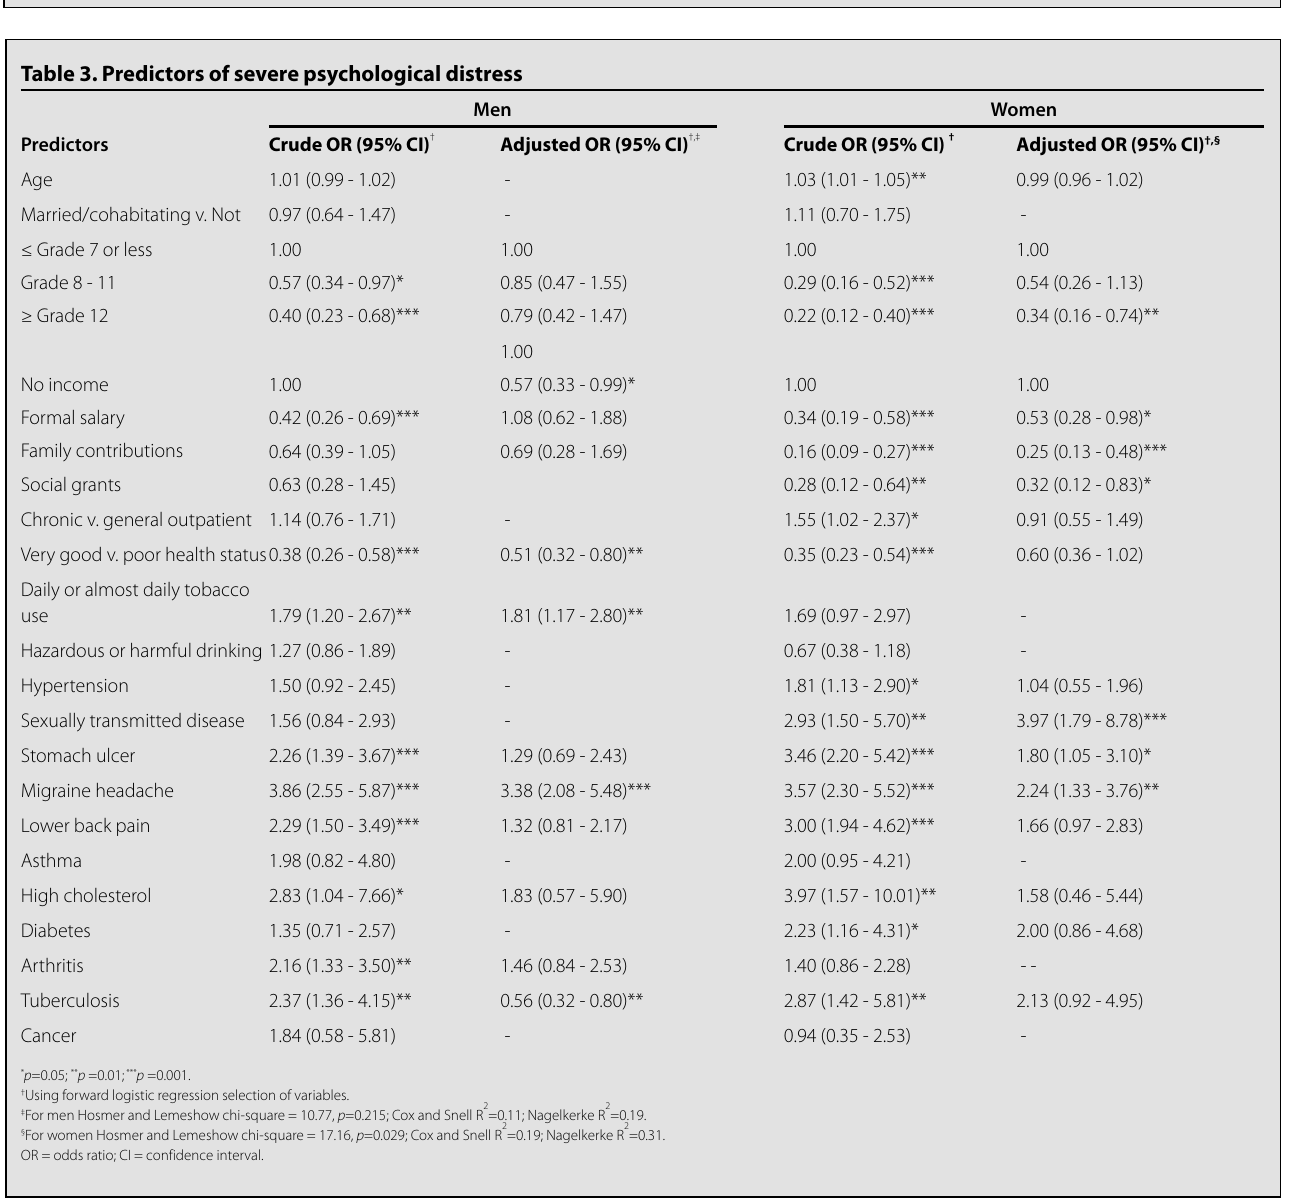
Table 3. Predictors of severe psychological